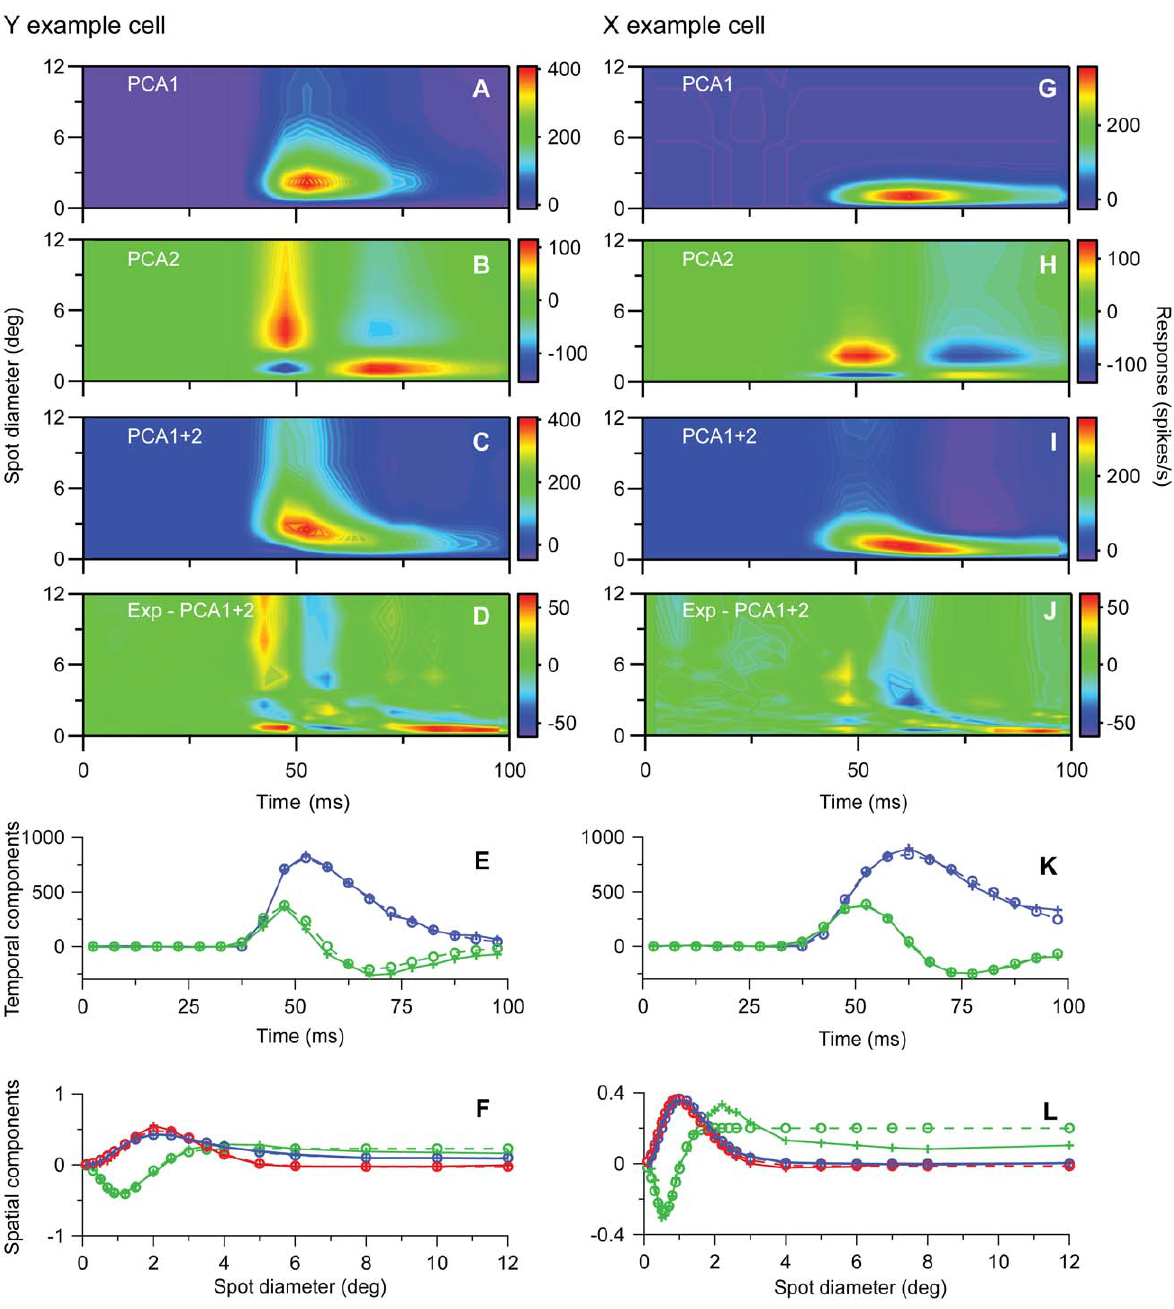
Figure 9. Principal components analysis (PCA) of early part of response data (t , 100 ms) for example on-center Y and X neurons in Figs. 1 and 2. A , B , 1 st and 2 nd principal components, respectively, for the Y-neuron response data, i.e., contributions from terms with n=1 and n=2 in Eq. (3). C , Sum of contributions from two first principal components (and background activity) for Y neuron. D , Deviation between experimental results for Y neuron and PCA results in (C). Error e (cf. Eq. 1) is 0.044. E , Fitted transient temporal function F t1 ( t ) (Eq. 11, blue dashed line) to 1 st temporal PCA component (blue solid line), and fitted transient temporal function F t2 ( t ) (Eq. 12, green dashed line) to 2 nd temporal PCA component (green solid line) for early part ( t , 97.5 ms) of Y-neuron data. F , Blue dashed line: Fitted DOG spatial functions (Eq. 10) to 1 st spatial PCA component of early part (t , 97.5 ms) of Y-neuron data (blue solid line). Green dashed line: Corresponding DOG function fit to the 2 nd spatial PCA component (green solid line). The best fit of a DOG function (red dashed line) to the 1 st spatial PCA component of the last part of the Y-neuron data is also shown (red line). G–L , Same as (A)–(F) for X-neuron response data. The deviation between experimental results and PCA results (I) corresponds to an error e =0.021.